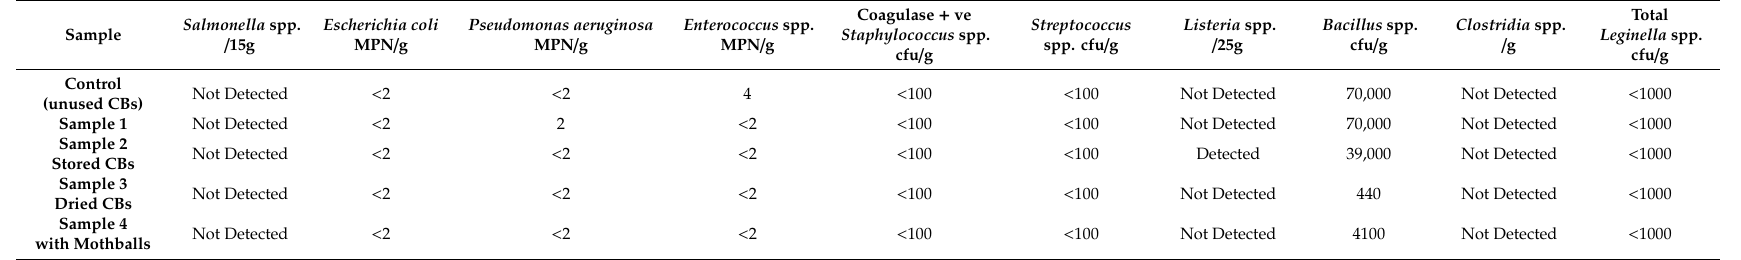
Table 4. Preliminary bacteriological test results for used, unused, and dried used CBs and CBs with mothballs (Pilot investigation